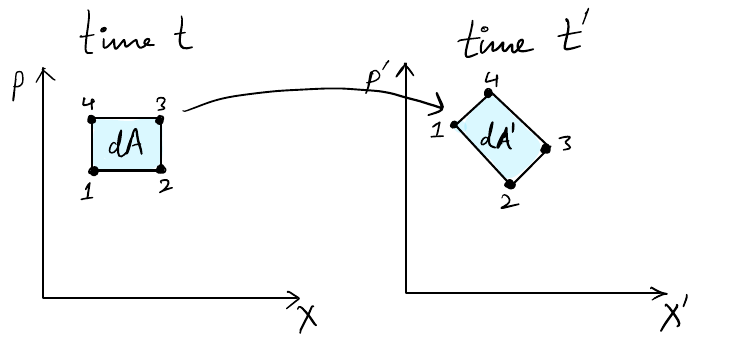
Figure 5: A representation of conservation of phase space area under the evolution of the system. See text for